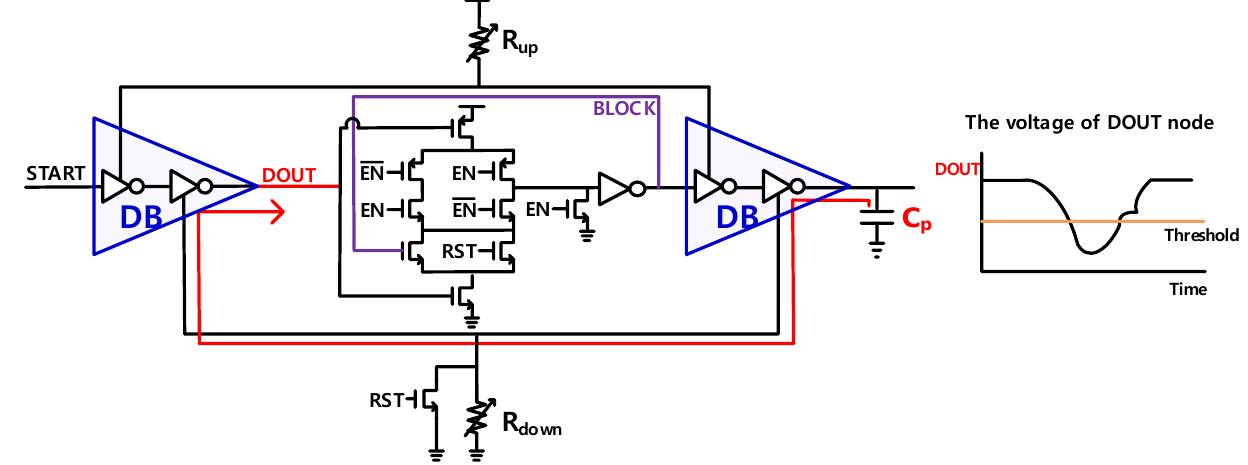
Figure 9. The schematic of the blocking method in proposed delay